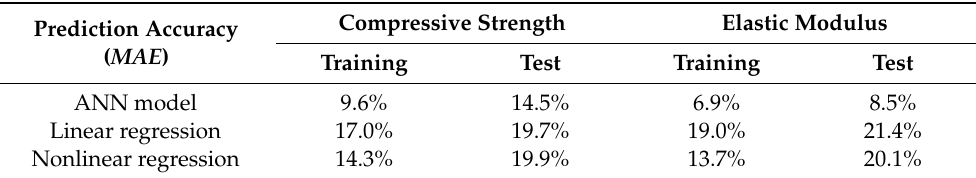
Table 6. Prediction accuracies of ANN, MLR, and MNLR